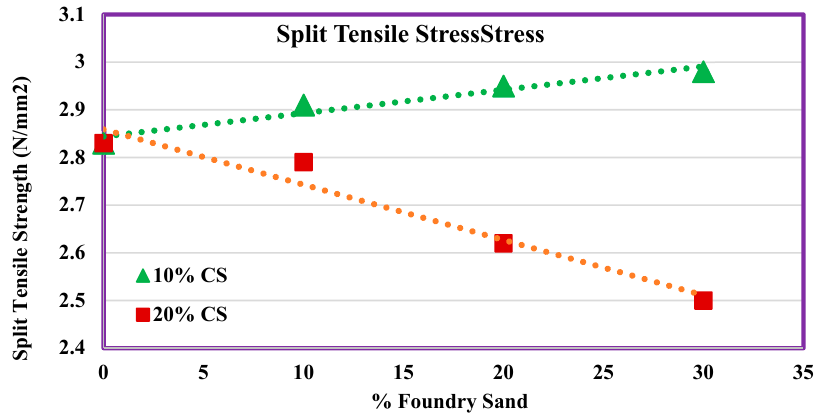
Figure 13. Split tensile strength contains various percentages of FS as well as CS.